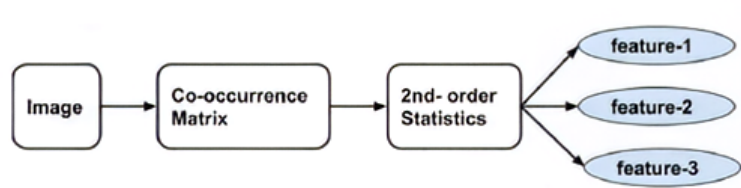
Figure A2. ( a ) The eight angles for directions, ( b ) computation of co-occurrence matrix, ( c ) image ( d ) image and grey-level co-occurrence matrix of the image.